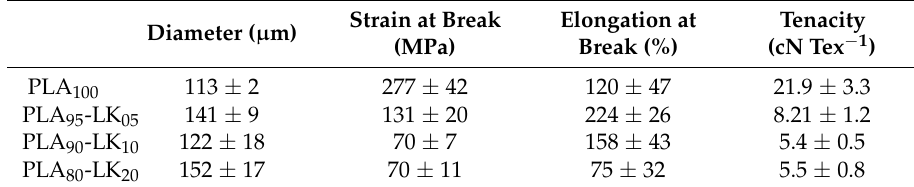
Diameters and mechanical properties (tensile test) of monofilaments extracted from